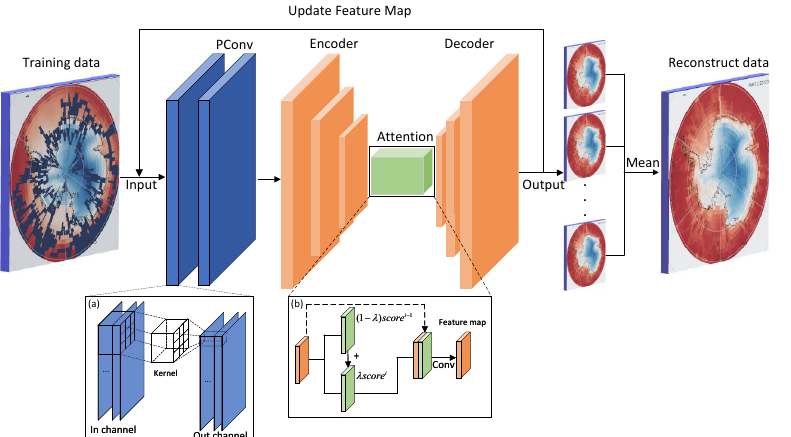
Figure 1. The overall network structure consists of input, partial convolution, encoder, attention mechanism, decoder and output modules. The masked reanalysis data and mask are fed into the network. The convolution operation in partial convolution is shown in ( a ). The unfolded structure of the attention mechanism is shown in ( b ), where λ is a learnable parameter, score i represents the attention score of step i , and score i − 1 is the attention score of the previous